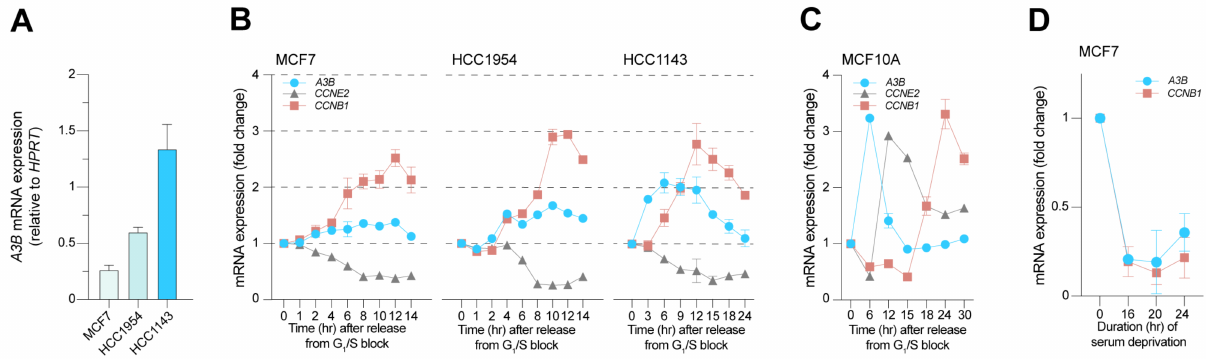
Figure 2. A3B expression in relation to cell cycle markers CCNE2 and CCNB1 . ( A ) Levels of en- dogenous A3B mRNA expression during normal culture of A3B-low (MCF7), A3B-intermediate (HCC1954), and A3B-high (HCC1143) breast cancer cells (n = 3). ( B ) Expression of A3B , CCNE2 , and CCNB1 in MCF7, HCC1954, and HCC1143 released from G 1 /S arrest, induced by a double-thymidine block. The peak in CCNB1 expression denotes the G 2 /M phase, whereas CCNE2 drops soon after release since CCNE2 expression is high throughout G 1 . The different sampling times are chosen to accommodate the differences in the growth speed of the used cell lines. Error bar represents SD. MCF7 and HCC1954 data represent n = 2 independent experiments; HCC1143 data represent n = 6 independent experiments. ( C ) Cell cycle progression and A3B expression in the normal-like breast epithelial cell line MCF10A, which expresses very low levels of A3B . Data represent n = 2 independent experiments. ( D ) Gene expression levels of A3B and CCNB1 as measured in MCF7 breast cancer cells after varying lengths of serum deprivation. Values relative to normal growth conditions. Error bar represents SD. Data represent n = 2 independent